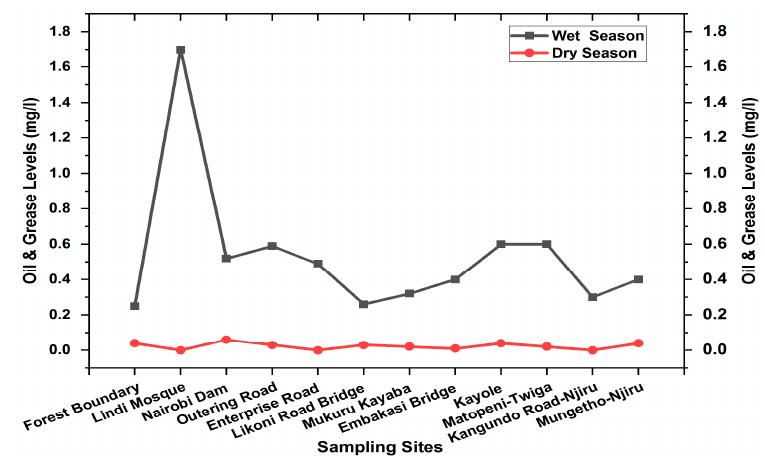
Figure 8. Oil and grease levels in Ngong River measured between April and August 2021.